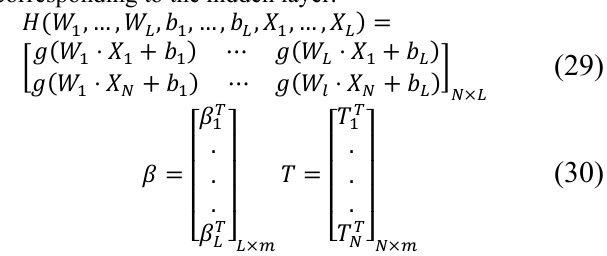
Fig 9. Structure of